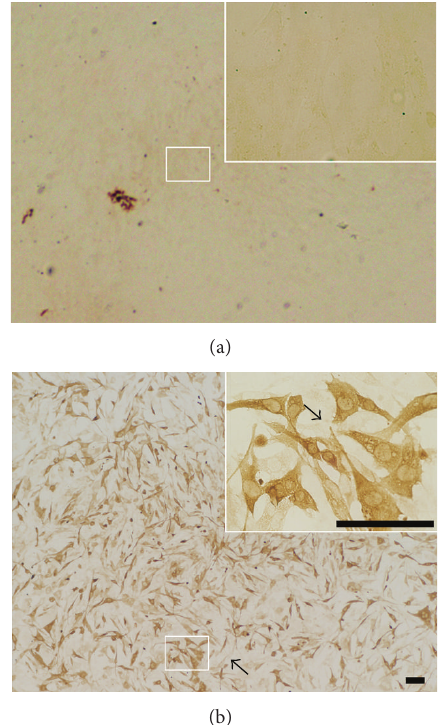
Figure 2: Immunohistochemical analysis of fibroblasts transfected with rAd-TH. (a) It demonstrates the control cells infected by the empty vector. (b) About 85% of the fibroblasts were positive for TH. The untrasfected fibroblasts were only shown in their unclear shape (pointed by arrow). The right upper figure is an enlargement of the main figure. Bar = 100 𝜇